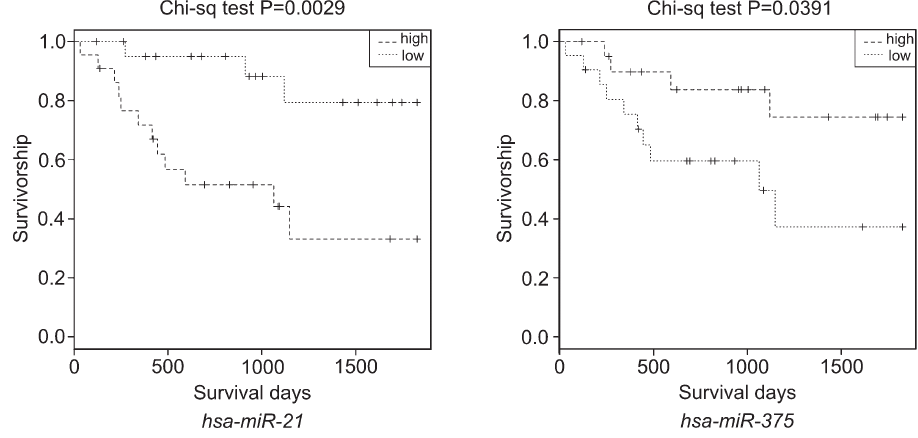
Figure 1. Survival analyses of hsa-miR-21 and hsa-miR-375 in esophageal squamous-cell carcinoma